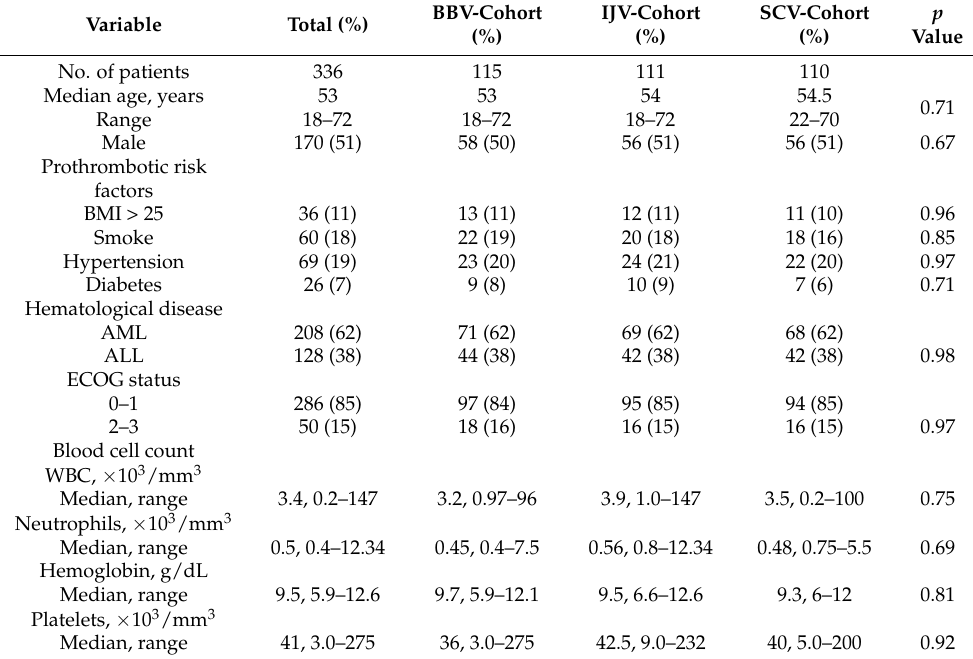
Table 1. Patients’ characteristics at baseline, according to the site of the